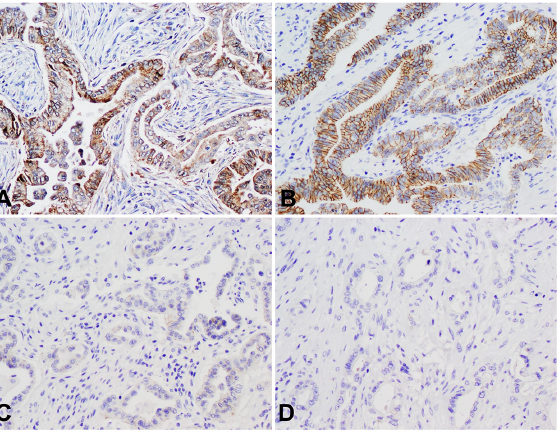
Fig 2. Expression of MAP4K5 correlates with the expression of E-cadherin in pancreatic ductal adenocarcinomas. A & B, Representative micrographs show strong cytoplasmic staining for MAP4K5 and strong membranous staining for E-cadherin in a pancreatic ductal adenocarcinoma. C & D, Representative micrographs show loss of MAP4K5 expression and the loss of E-cadherin expression in a pancreatic ductal adenocarcinoma. Original magnifications: